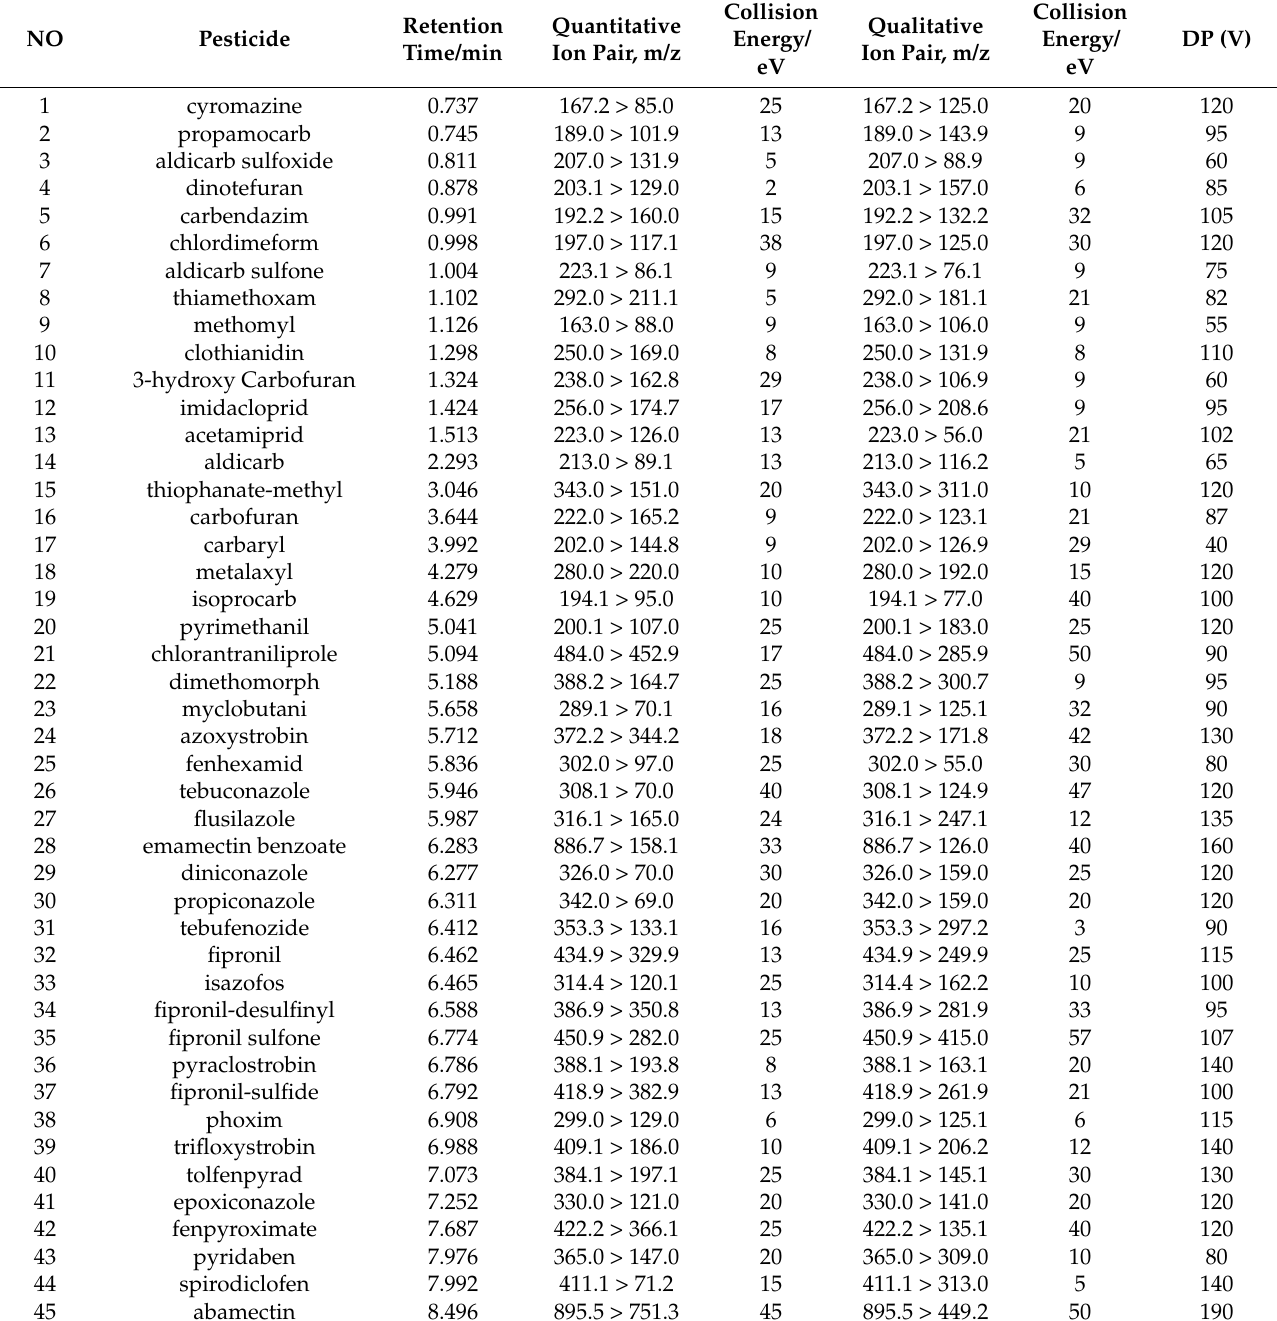
Table 1. The MRM acquisition